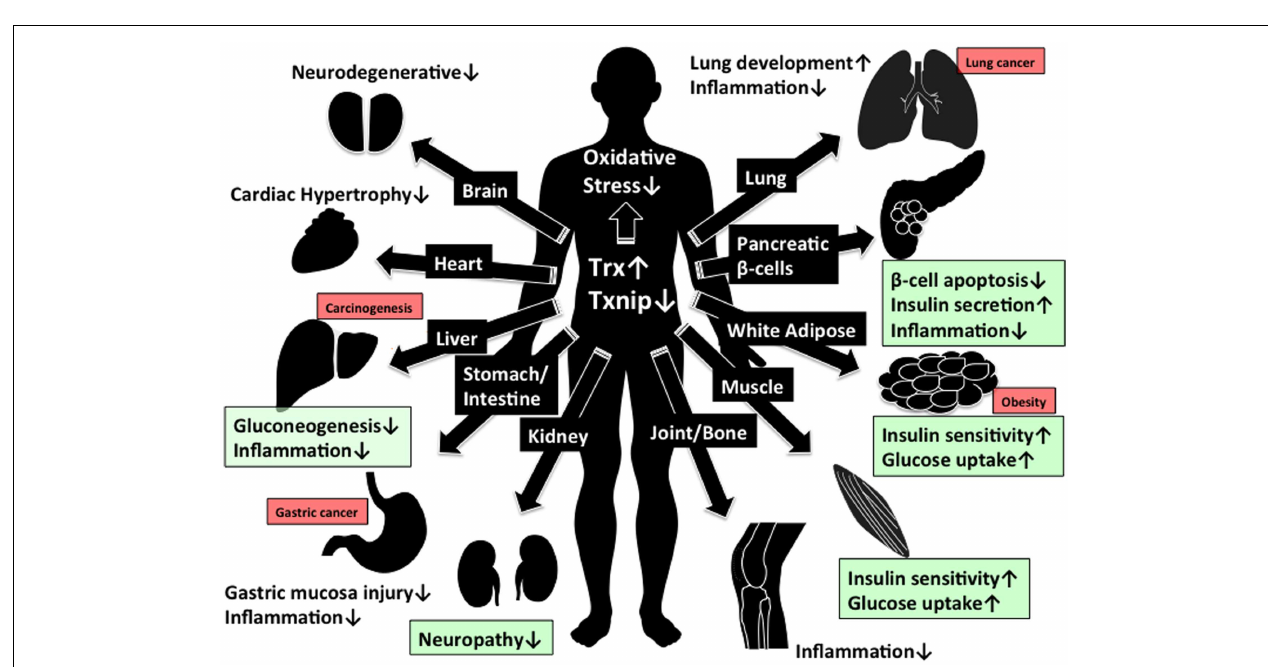
FIGURE 2 | Beneficial effect ofTrx1/Txnip signaling for clinical aspect .The beneficial effect by increasing ofTrx1 and decreasing ofTxnip expression are shown. Green box indicate the beneficial effect in diabetes while red box indicate the concern about adverse effect in cancer development by reducedTxnip